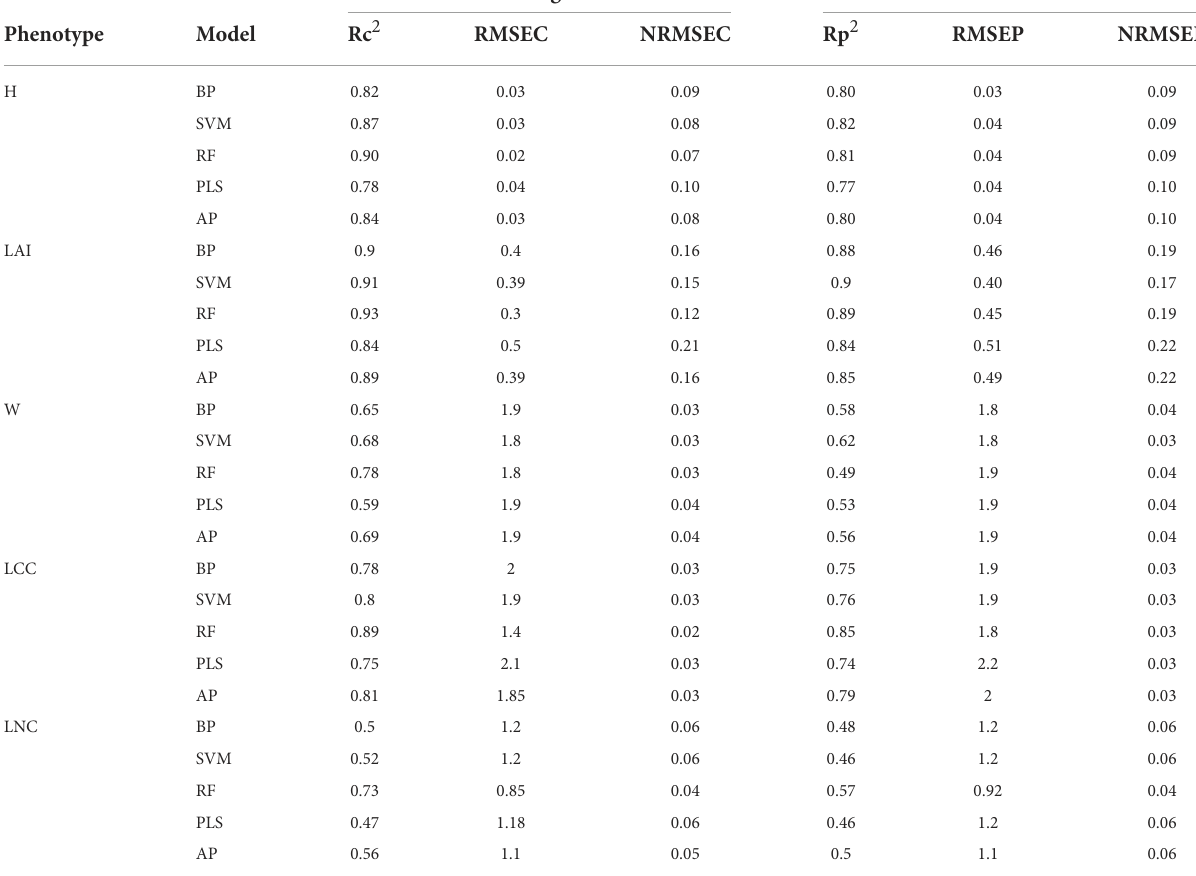
TABLE 5 Phenotypic evaluation of tea plants based on multi-source remote sensing. Training sets Test